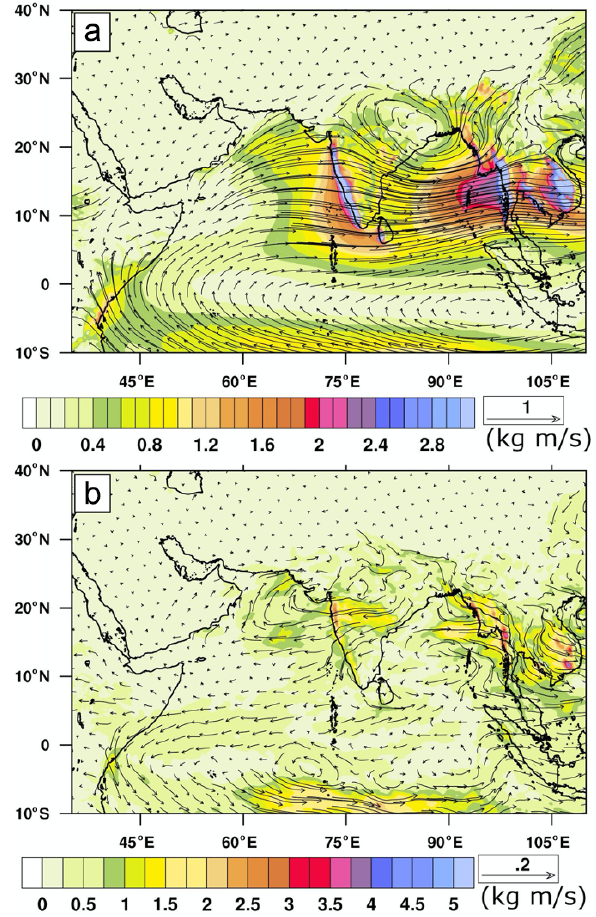
Figure 18. JJAS horizontal transport of cloud water (arrows show the vector of cloud water transport, the color scale is its module) in INDJ (a) and INDB–INDJ difference (b)